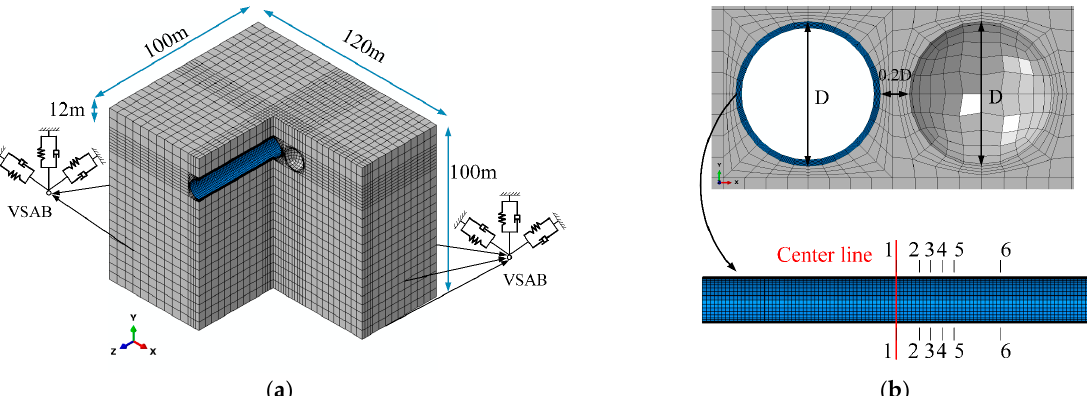
Figure 5. A 3D model of the tunnel with lateral karst cavity: ( a ) 3D finite element model of under ‐ ground structure with VSAB, and ( b ) cross ‐ section details and the locations of six typical sections.